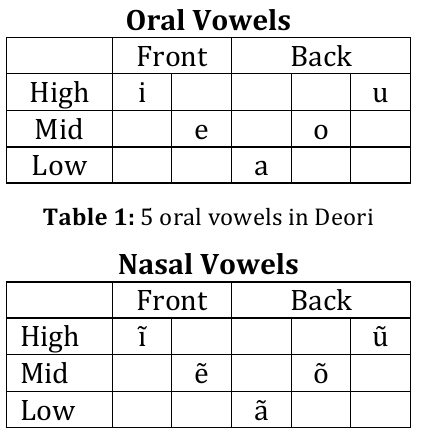
Table 2: 5 nasal vowels in